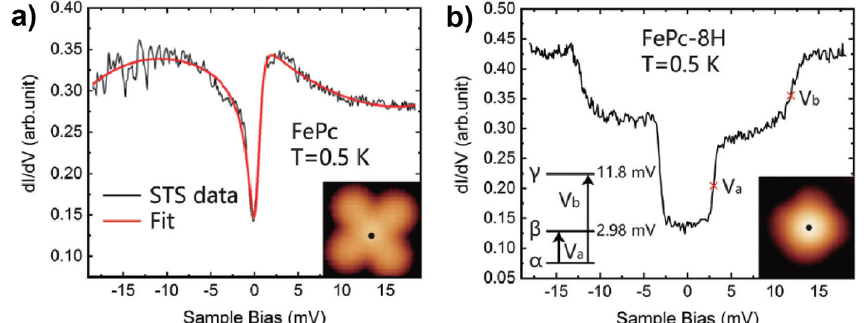
Figure 5. ( a ) d I / d V spectrum of intact FePc on Au(111). Inset: STM image of intact FePc. ( b ) d I / d V spectrum of dehydrogenated FePc absorbed on Au(111). Inset: Schematic diagram of the split spin states (bottom left) and STM image of dehydrogenated FePc (bottom right). Adapted from [67], with permission from the Royal Society of Chemistry, 2018.